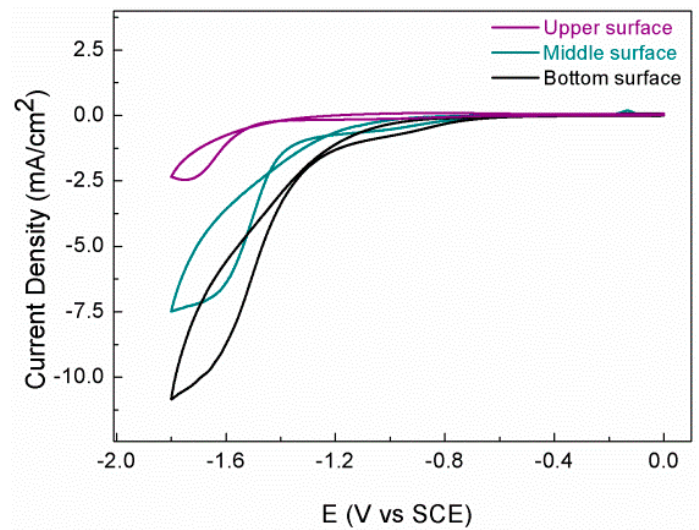
Figure 5. Cyclic voltammograms for CaP electrodeposition on SLM-Ti scaffolds with micro-reference electrode placed at different thickness.